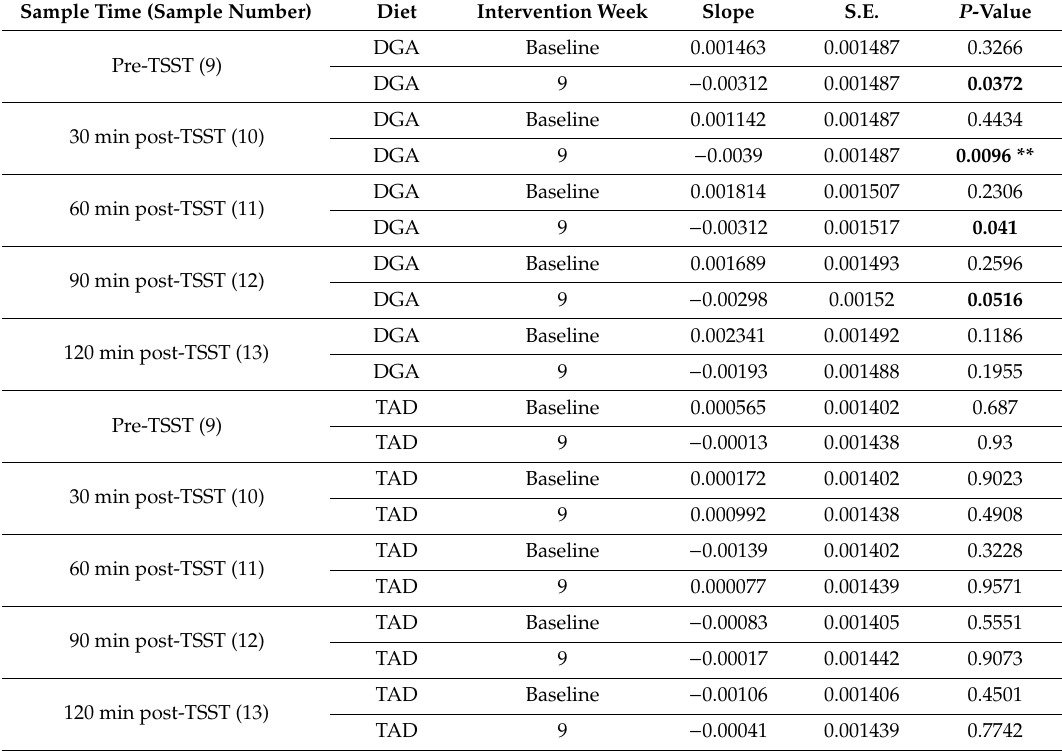
Table 1. * Slope estimates for association between log salivary cortisol concentration and ∆